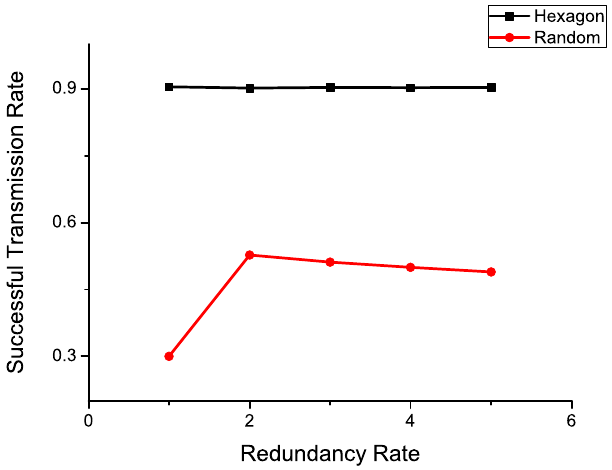
Figure 11. Data successful transmission rate (S) under different